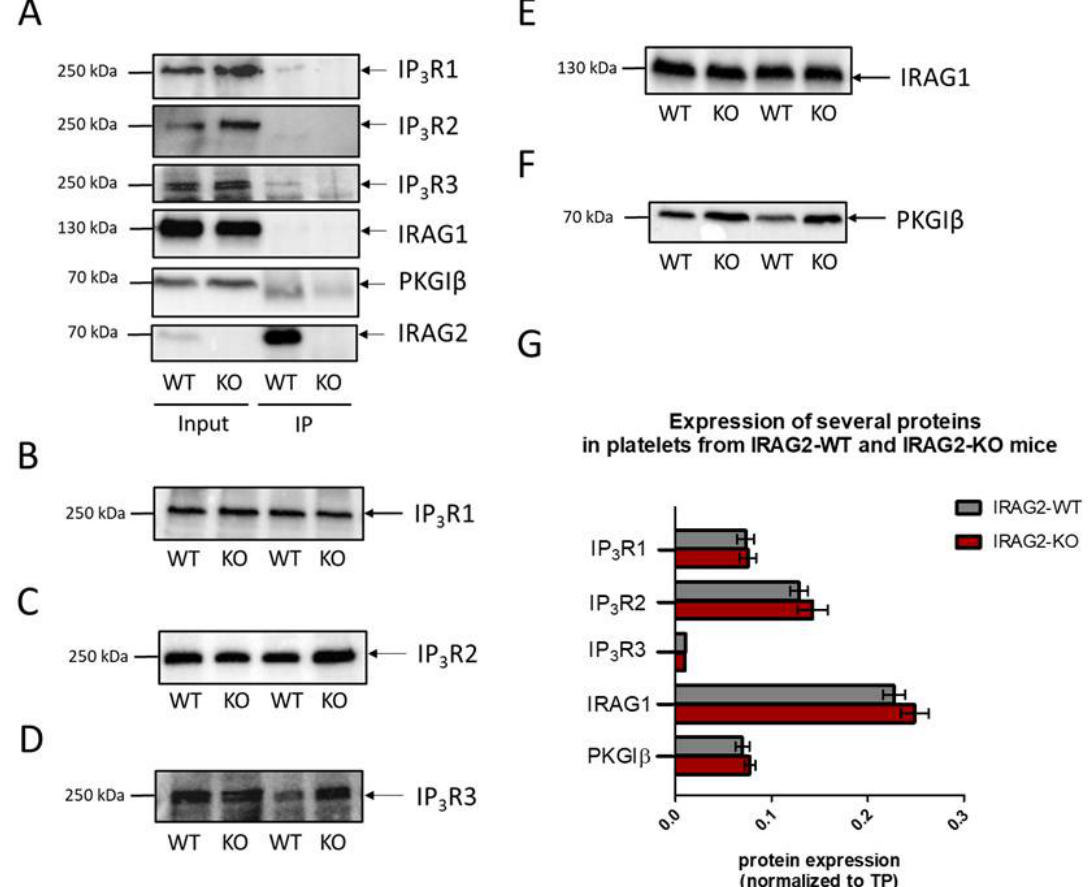
Figure 2. Interaction of IRAG2 with IP 3 receptors ( A ) and expression of several proteins in platelets from IRAG2-WT (WT) and IRAG2-KO (KO) mice ( B – G ). ( A ) Immunoprecipitation of IRAG2 with IRAG2-specific antibody and Western Blot analysis of co-immunoprecipitated interaction partners. An amount of 70 µg of protein was used as input probe and 1000 µg of protein for immunoprecipi- tation. ( B – F ) Representative Western Blots for protein expression of IP 3 R1-3, IRAG1 and PKGIβ. ( G ) Signal intensity of each band was quantified and normalized to total protein (TP) of the appropriate Lane for quantification. Expression of IP 3 R1 (WT: n = 11; KO: n = 11), IP 3 R2 (WT: n = 5; KO: n = 5), IP